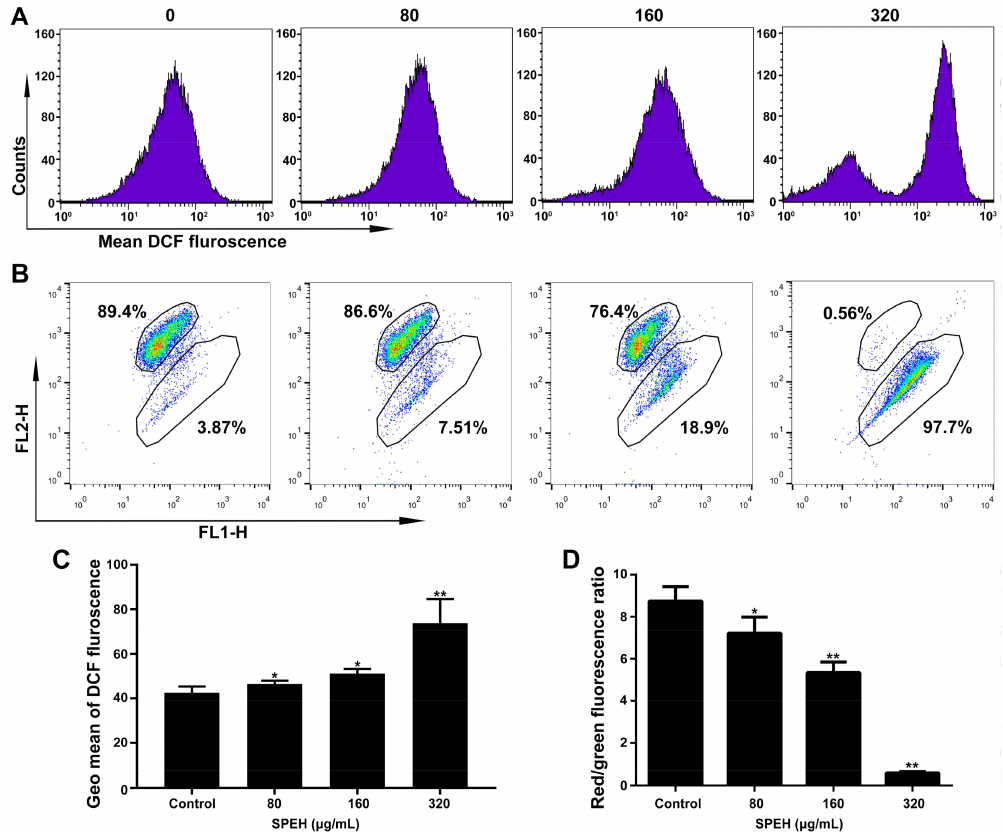
Figure 4. SPPH induced ROS generation and MMP loss in SGC-7901 cells. ( A ) After treatment with SPPH for 36 h, SGC-7901 cells were stained by ROS indicator (DCF-DA) and ROS levels were measured by flow cytometry; ( B ) MMP detection of SGC-7901 cell using JC-1 probe by flow cytometry; ( C ) Average DCF fluorescence, indicated by Geo Mean, was shown in the histogram; ( D ) Average fluorescence intensity was indicated by histograms. Data are expressed as Mean ± SD ( n = 3). ** p < 0.01 versus control, * p < 0.05 versus